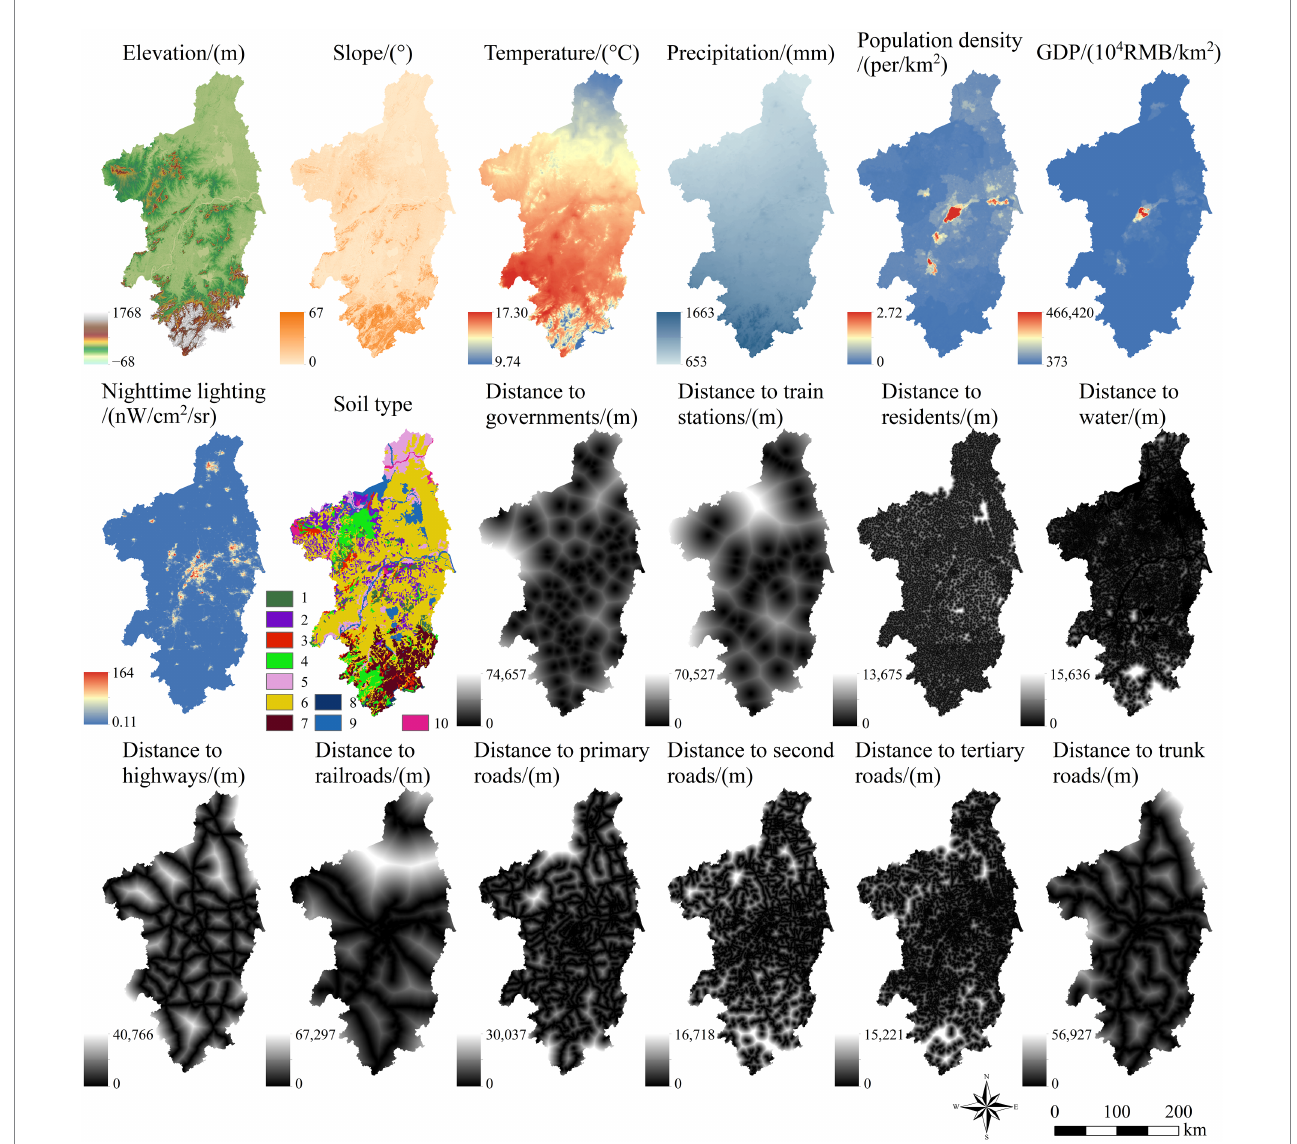
FIGURE 3 The 18 driving factors affecting LULC. Note: The legend of soil type represents, 1: yellow-brown soils; 2: yellow-cinnamon soils; 3: limestone soils; 4: chisley soils; 5: fluvo-aquic soils; 6: paddy soils; 7: red earths; 8: yellow earths; 9: water; and 10: others.